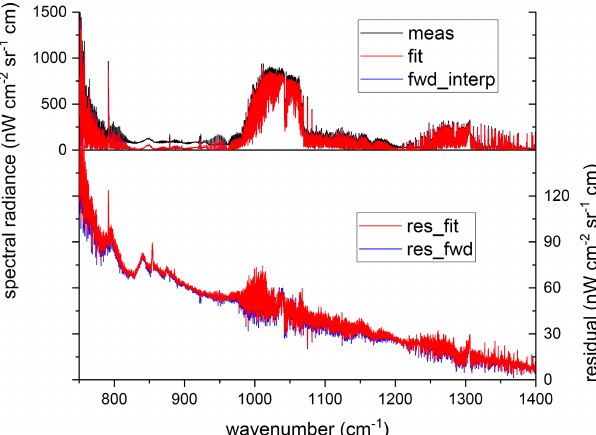
Figure 2. Original measured spectrum without subtraction of the Planck function (black), forward-calculated spectrum from the fit results (red), and linearly interpolated spectrum from the forward calculations for the lowermost and uppermost detector rows (blue, hidden by the red line). The lower panel shows the residuals (mea- sured minus fit in red and measured minus interpolated forward cal- culation in blue) enlarged by a factor of 10, demonstrating the very small difference between the fitted and forward-calculated interpo- lated